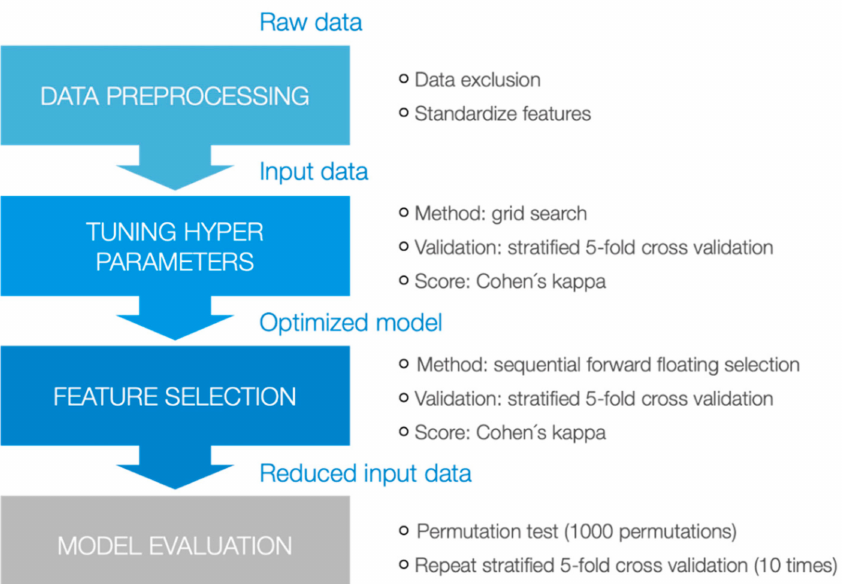
Figure 1. Workflow of the methodology for the application of the machine learning techniques. First, raw data were preprocessed. Gait parameters of each diagnostic gait system formed one data set (DIERS data, GAITRite data, and Mobility Lab data). These data sets were used as input features, with only metric features present in the data sets. Four participants in the Mobility Lab data set were excluded due to missing values. All features were standardized before applying the classification